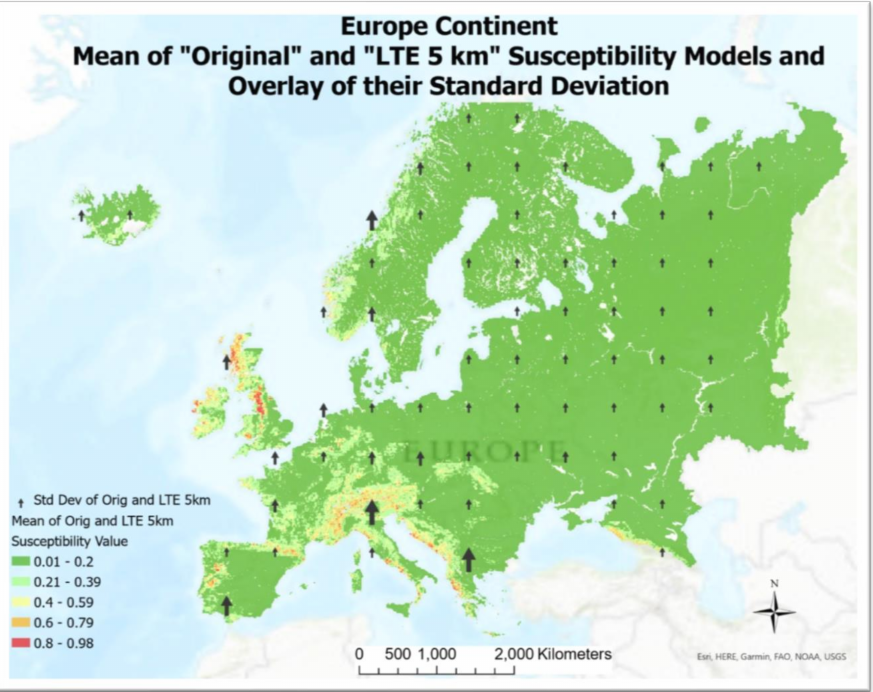
Figure 10. Overlay of susceptibility standard deviation and mean of two combined models (“Original” and “LTE 5km”). Standard deviation is represented by a scalar (black arrows), smaller arrows = lower values, etc. Warmers colors represent higher mean susceptibility. Base map is from ArcGIS ® , the intellectual property of Esri, used herein under license. Copyright©